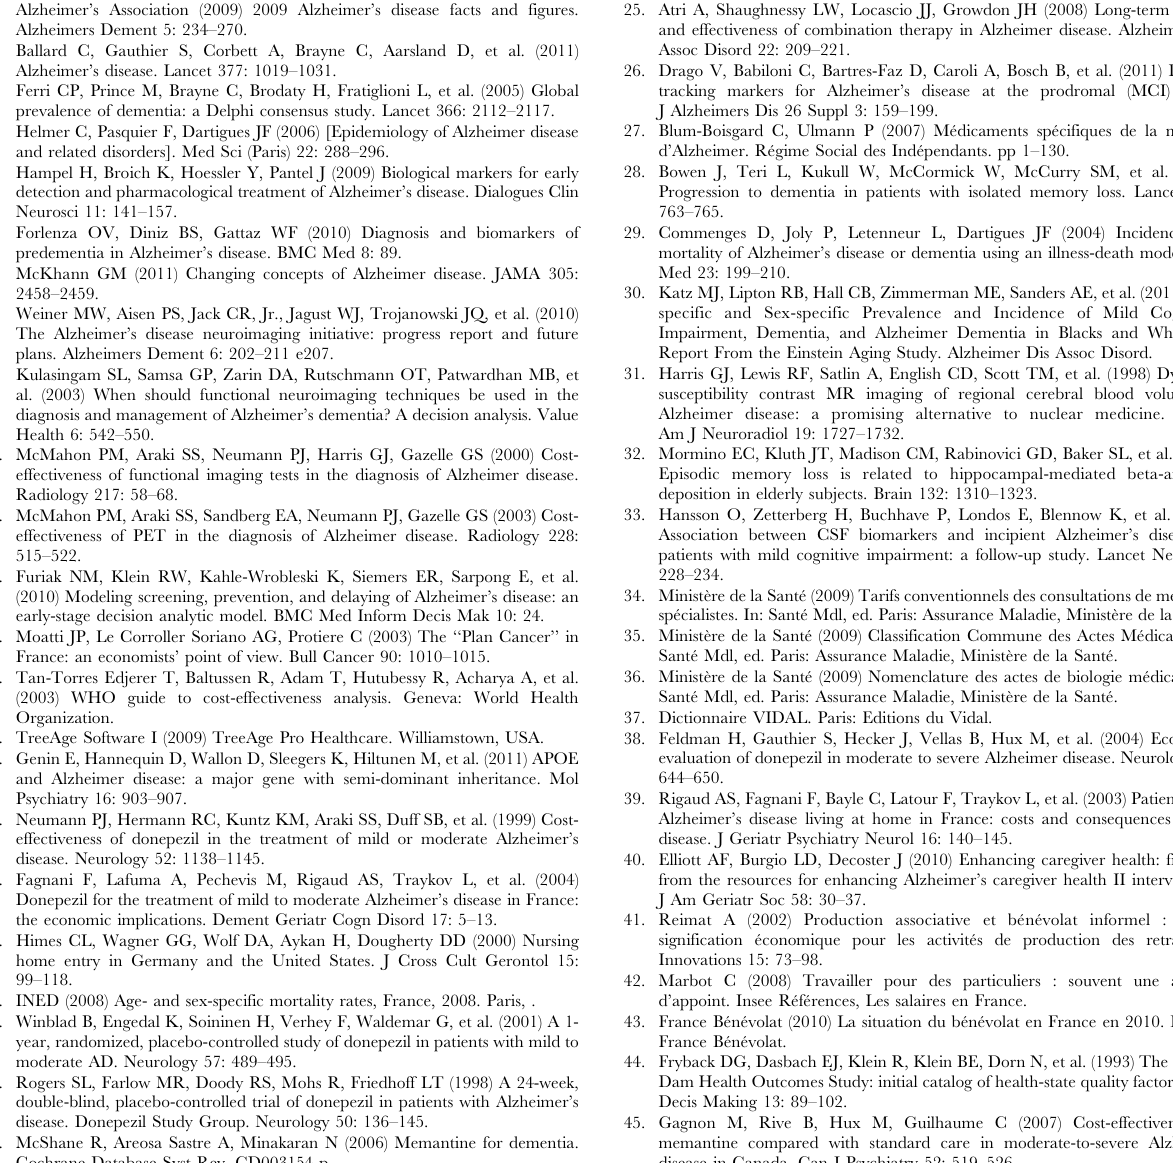
Table S3 Univariate sensitivity analysis: ICER of the MRI + CLP strategy compared with the reference strate- gy, in the universal ‘‘screen and treat’’ cost-effectiveness analysis, depending on the values of model